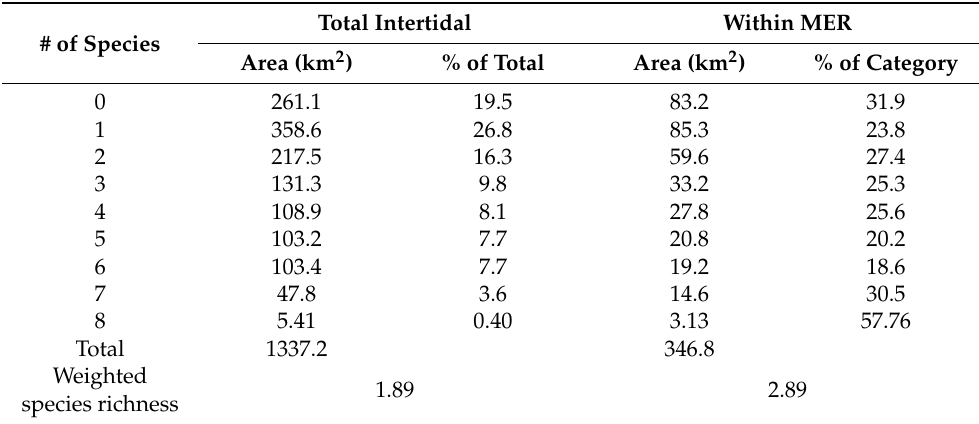
Table 3. Number of Shorebird species habitat present as predicted from Maxent models. Zero indicates that zero species had the pixel designated as habitat, while eight indicates eight species had the pixel designated as